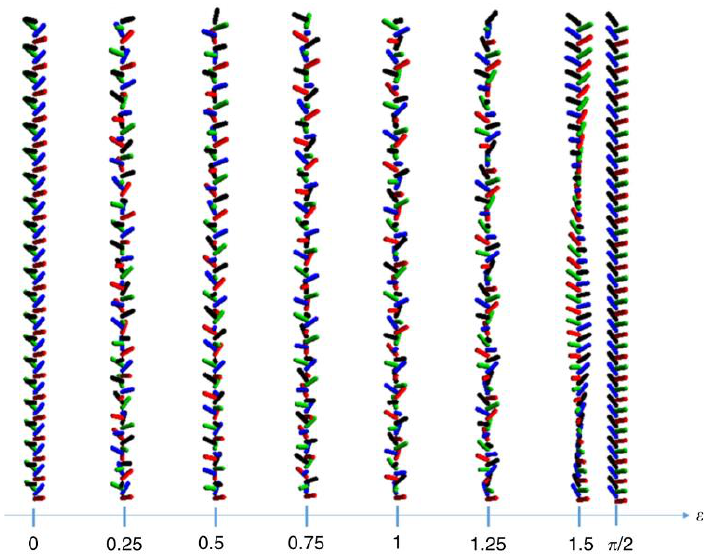
Figure 20. A schematic representation of the evolution of the four-layer structure in the SmC TB-DH phase on increasing 𝜀 , the difference between the azimuthal angle between adjacent layers. For clarity the tilt angle has been increased. (Taken from [94]).